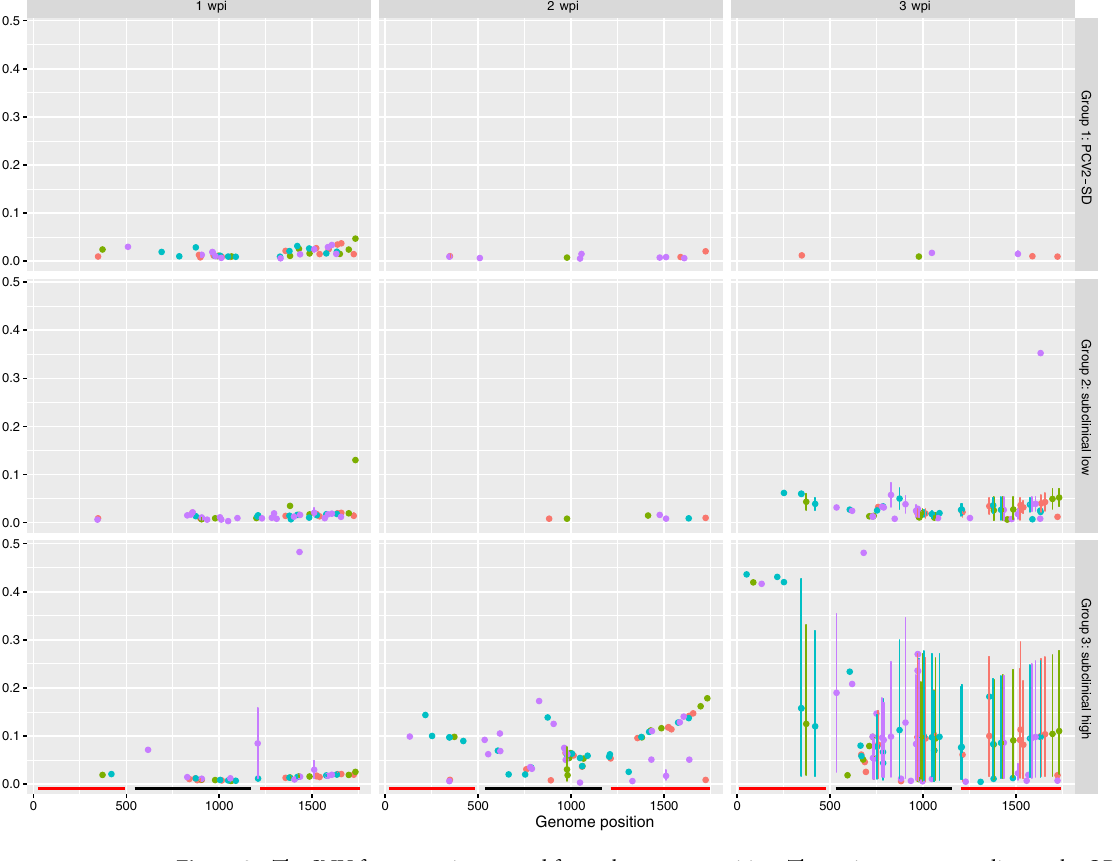
Figure 2. The SNV frequency is reported for each genome position. The regions corresponding to the ORF1 and ORF2 have been represented as red and black lines, respectively. Error bars indicate the presence of multiple subjects harboring the same SNV and describe the frequency variability. The wpi are reported as columns while the different groups are reported in separate